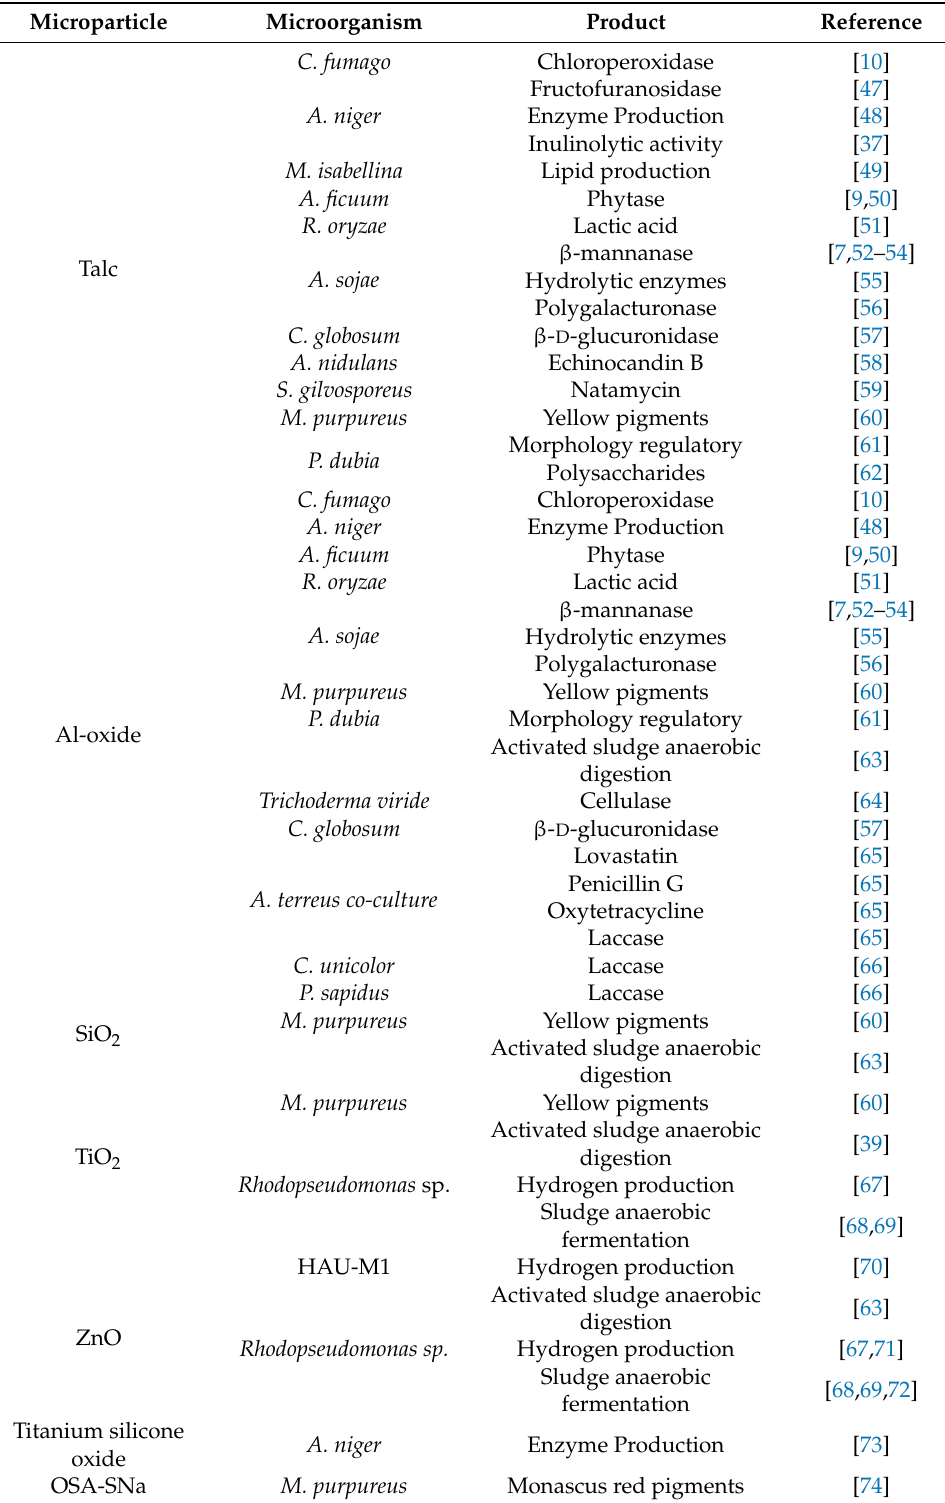
Table 2. Microparticles and their applications for biological